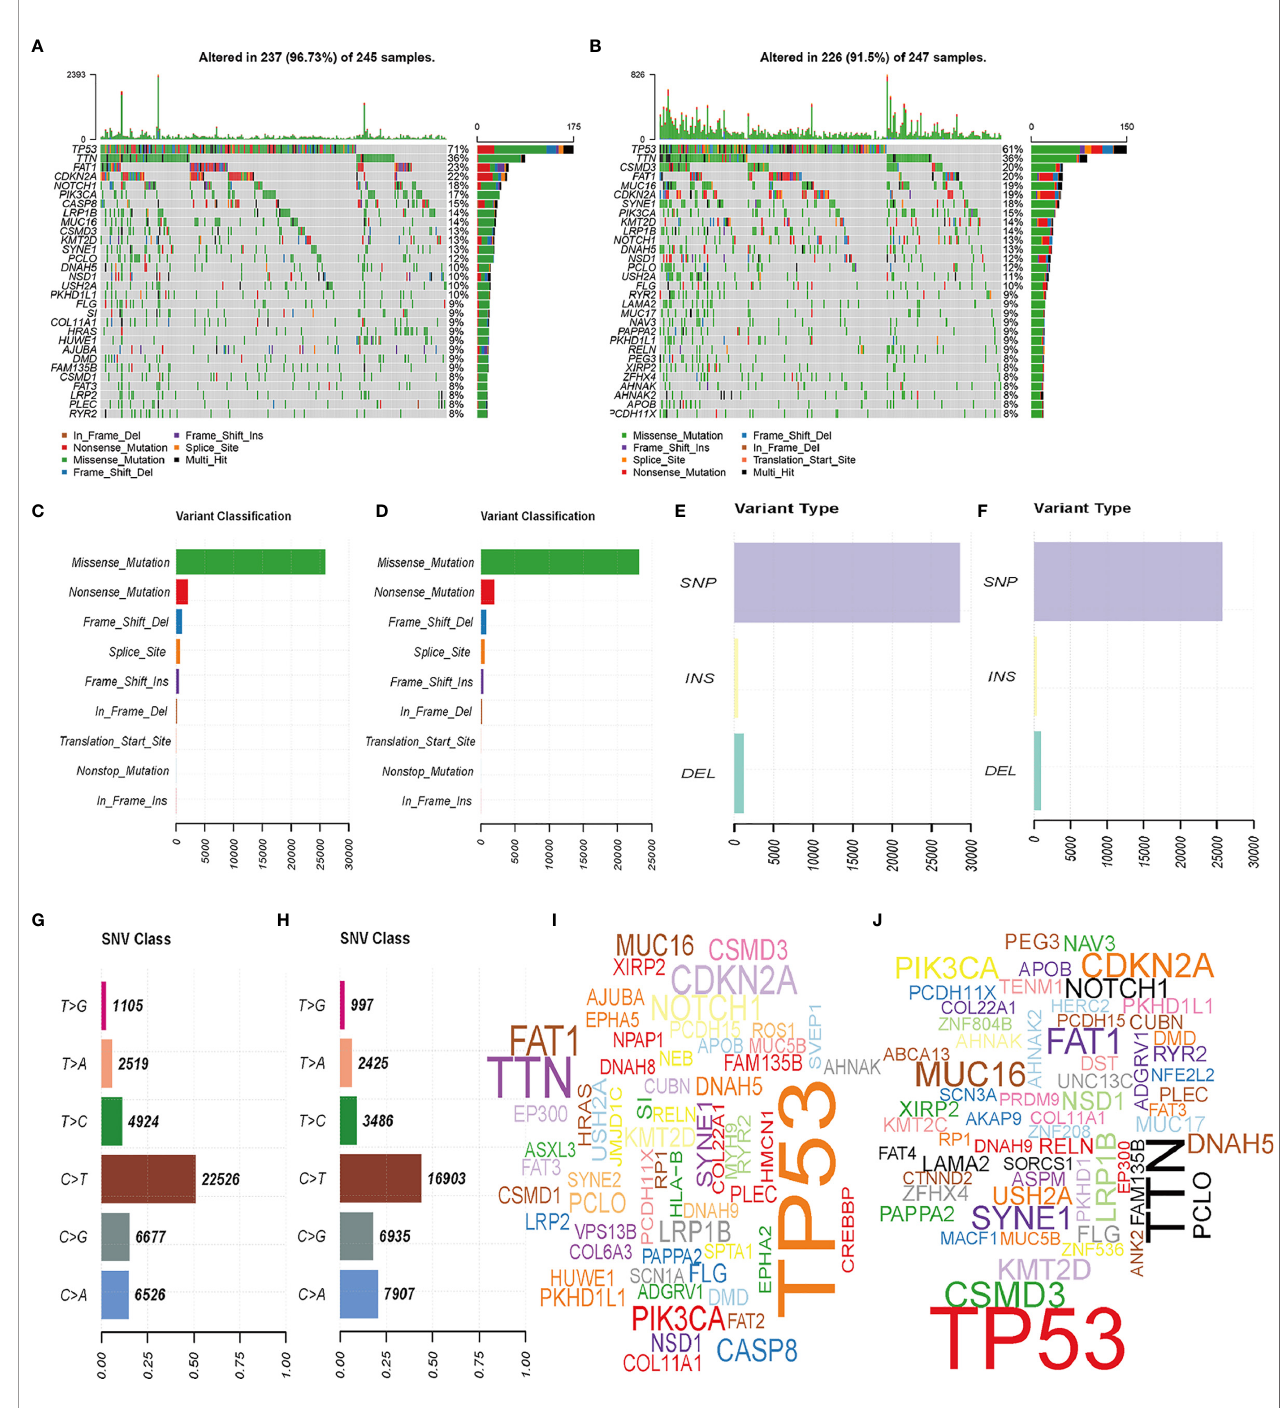
FIGURE 5 | Landscape of mutation pro fi les between high- and low-risk HNSCC patients. (A, B) Waterfall plots of mutation information in each sample. (C, D) Variant classi fi cation. (E, F) Distribution of genetic alterations. (G, H) SNV classes. (I, J) Gene clouds of mutation frequencies in HNSCC